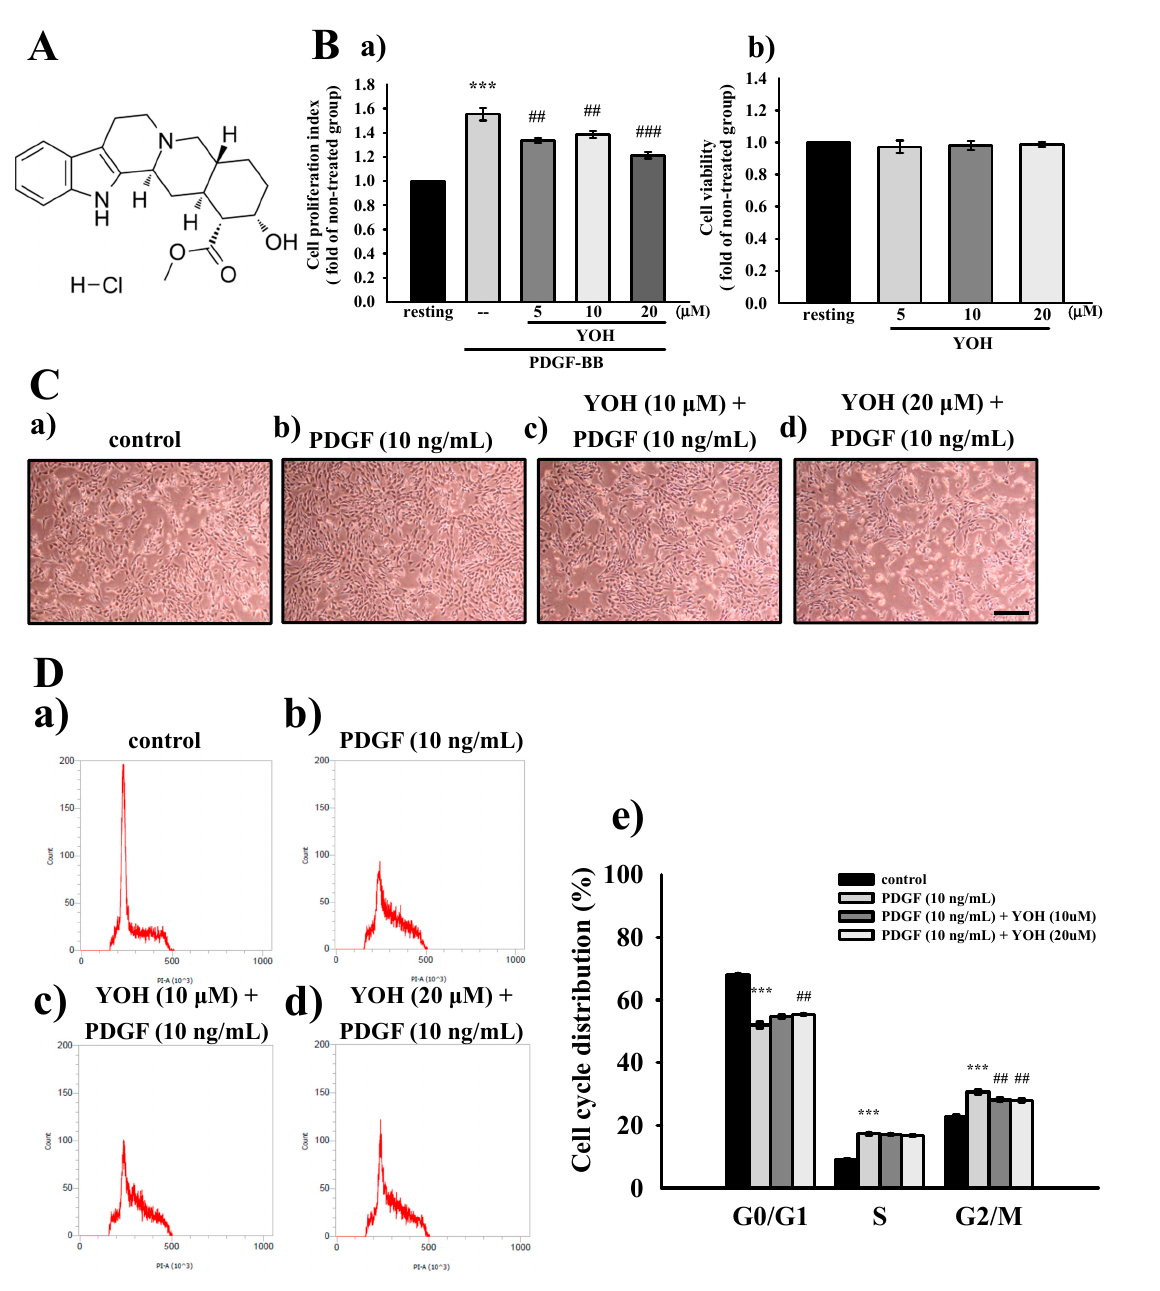
Figure 1. Effects of YOH on PDGF-BB-induced proliferation and cell cycle progression in